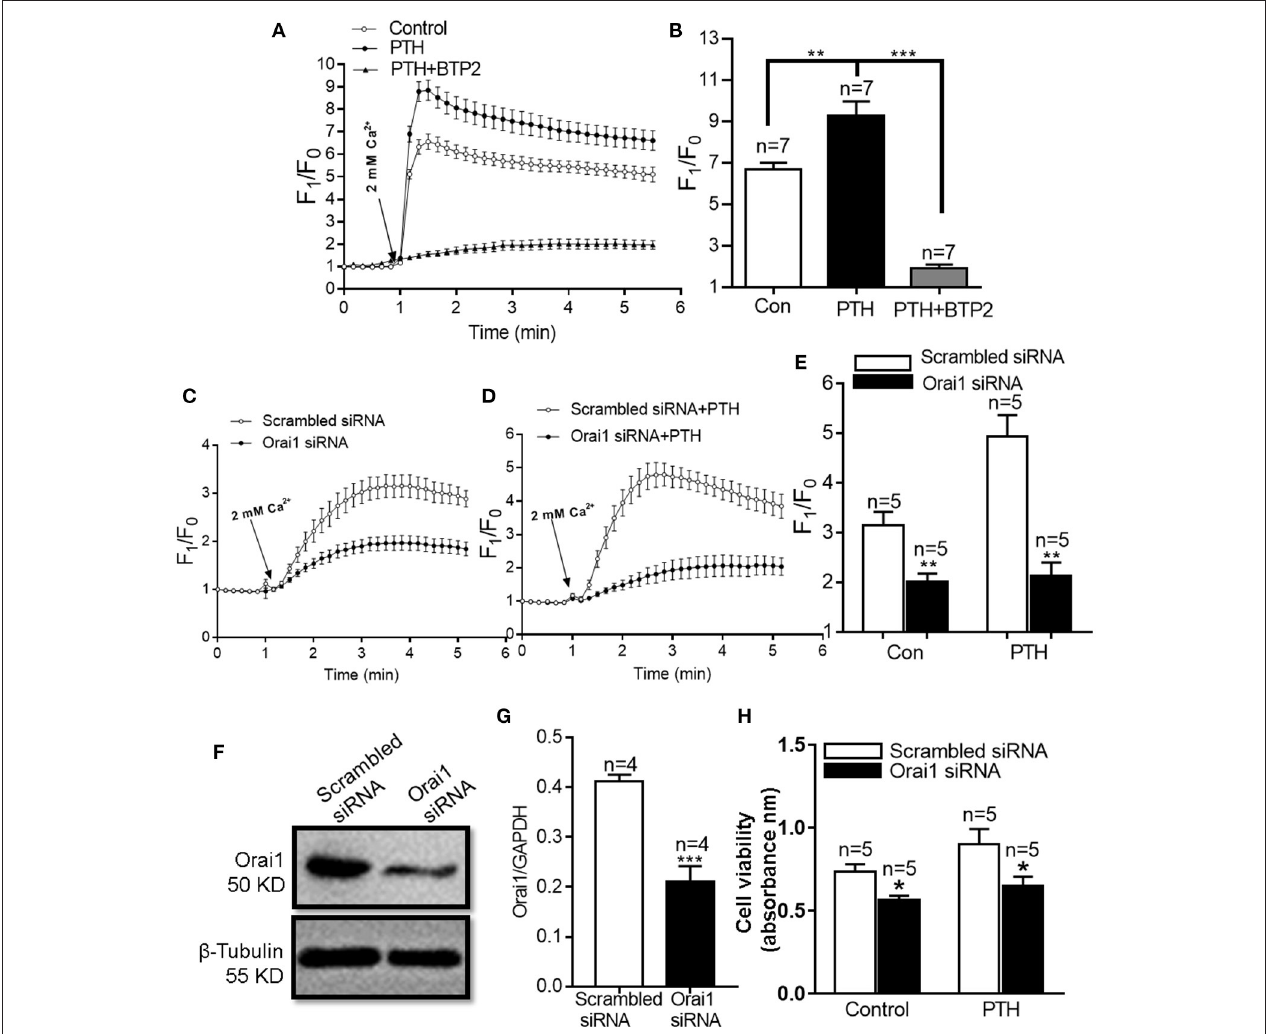
FIGURE 2 | Effect of parathyroid hormone (PTH) on store-operated Ca 2 + entry (SOCE) in human umbilical vein endothelial cells (HUVECs). (A,B) Representative traces (A) and summary data (B) showing thapsigargin (TG)-evoked SOCE in HUVECs after treatment with vehicle control, PTH (100 pM) or PTH plus BTP2 (an Orai nonspecific inhibitor) for 24h. After depletion of the intracellular Ca 2 + stores by treatment with 2 µ M TG for 10min in a Ca 2 + -free medium, SOCE was evoked by 2mM Ca 2 + application to the medium. Data are shown as the mean ± SEM; n = 7. ** P < 0.01, *** P < 0.001 vs. Con or PTH. (C–E) Representative traces (C,D) and summary data (E) showing TG-evoked SOCE in HUVECs transfected with scrambled siRNA or Orai1 siRNA and treated with vehicle control or PTH (100 pM) for 24h. (F,G) Representative images (F) and summary data (G) showing the effect of scrambled siRNA or Orai1 siRNA transfection on Orai1 expression in HUVECs. GAPDH was used as a loading control. (H) Summary data showing viability of HUVECs transfected with scrambled siRNA or Orai1 siRNA and treated with vehicle control or PTH (100 pM) for 24h. Data are shown as the mean ± SEM; n = 4–5. * P < 0.05, ** P < 0.01, *** P < 0.001 vs. Scrambled siRNA.